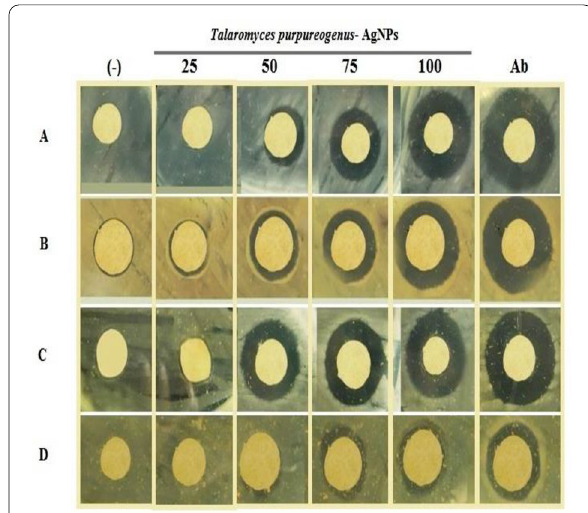
Fig. 8 Disc-Diffusion assay for antibacterial activity of T. purpureogenus AgNPs against A E. coli B Listeria monocytogenes C Shigella dysenteriae D Salmonella typhi